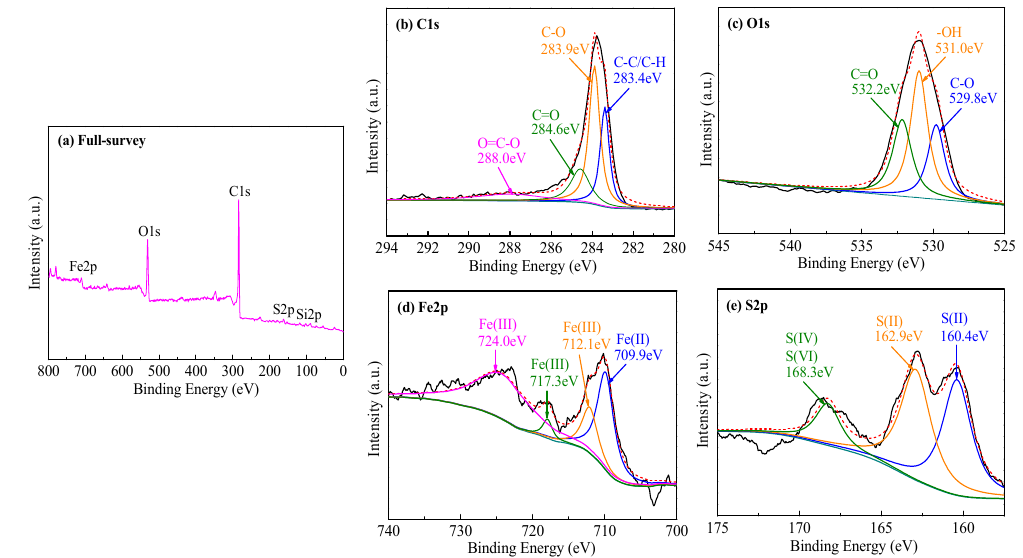
Figure 7. XPS spectra of MR–FeS@SC nanocomposite: ( a ) Full-survey spectrum and peak fitting curves of ( b ) C 1s, ( c ) O 1s, ( d ) Fe 2p, and ( e ) S 2p spectra.